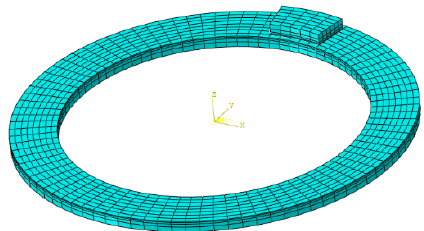
Figure 3. Three-dimensional contact finite element model of brake disc and brake shoe. Table 4. Loading procedure of the finite element analysis.